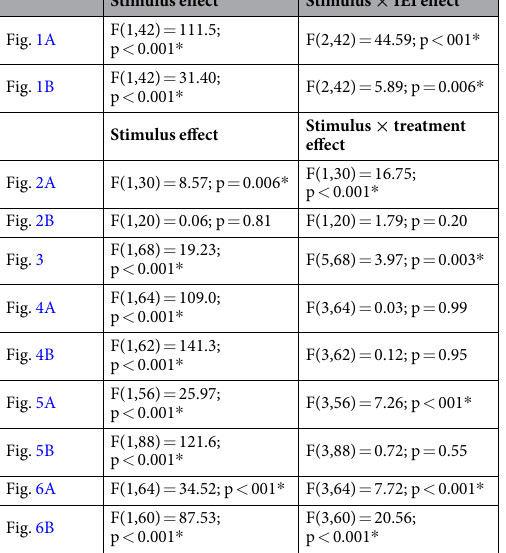
Table 1. Overall statistics for non-social and social memory as presented in Figs 1–6. IEI, inter-exposure interval. Stimulus effect refers to the novel and the same object and to the novel and the same juvenile. Two-way ANOVA for repeated measures followed by Bonferroni post-hoc test; * p < 0.05.